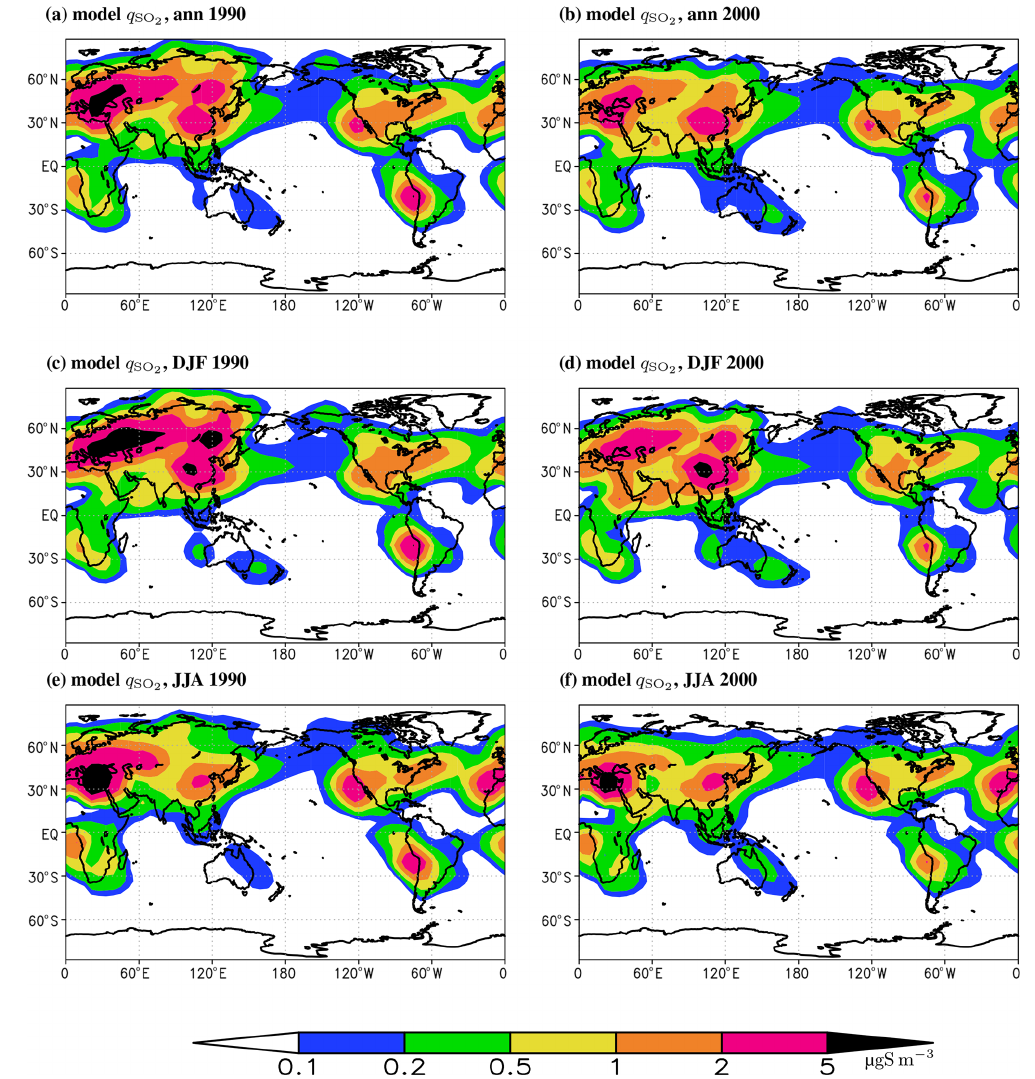
Figure 8. Similar to Fig. 4 but for the near-surface q SO